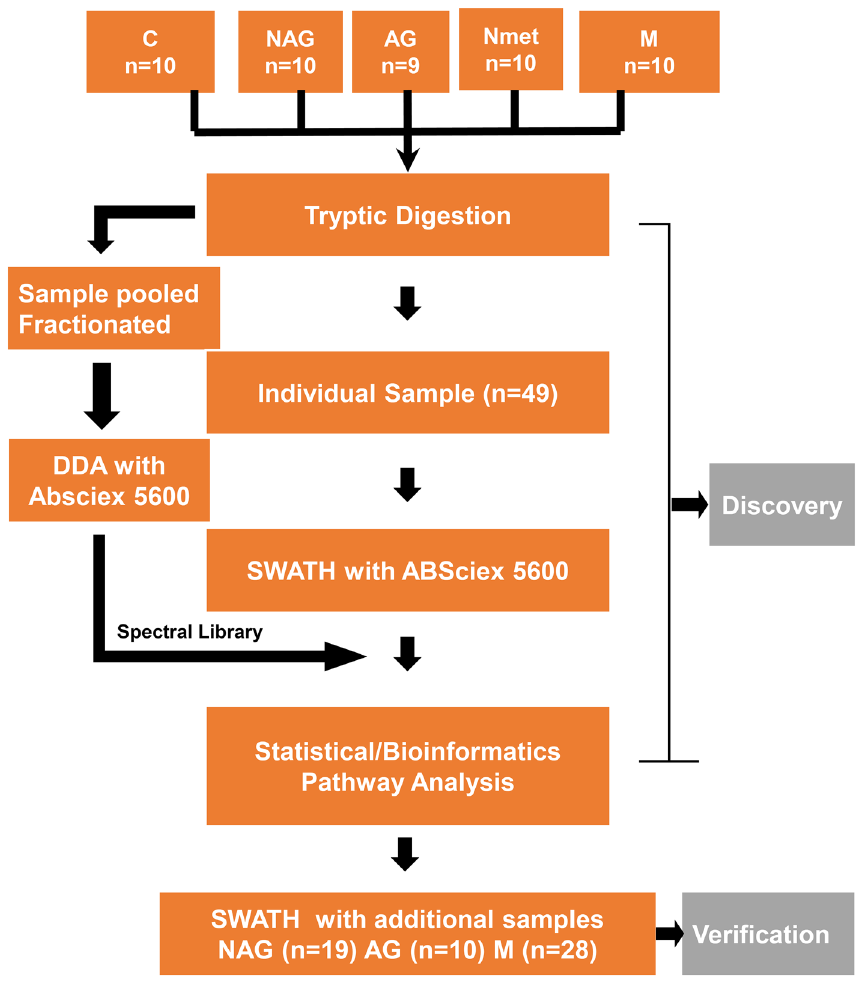
Figure 1. Schematic diagram of the workflow. First, we characterized the protein signatures of 49 cases in the discovery cohort, including 19 primary tumors (10 NAG and 9 AG), 20 metastatic tumors (10 Nmet and 10 M) and 10 benign controls (C). Next, we further validated our findings by the targeted re-examination of SWATH-MS maps using the independently collected cohort, including 29 primary PCa (19 NAG and 10 AG) and 28 metastatic tumors (M). C: benign control, NAG: non-aggressive PCa, AG: aggressive PCa, Nmet: metastasis without androgen deprivation therapy; M: metastasis with androgen deprivation